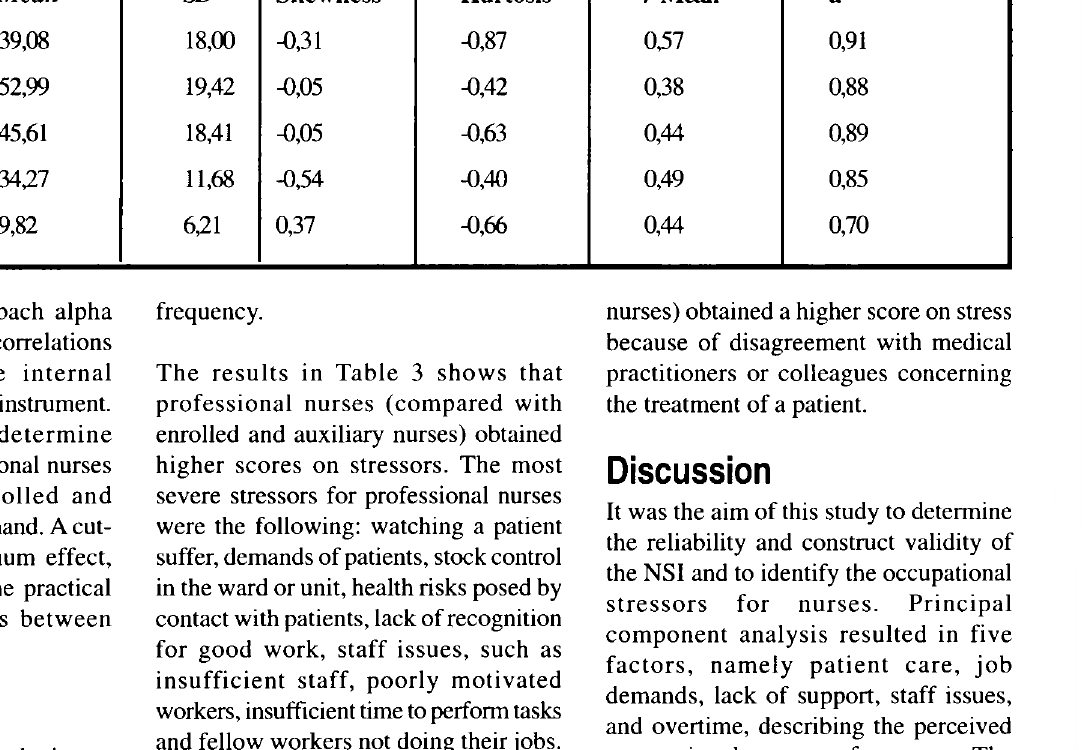
Table 4 Descriptive statistics, alpha coefficients and mean inter-item correlation coefficients of the NSI factors